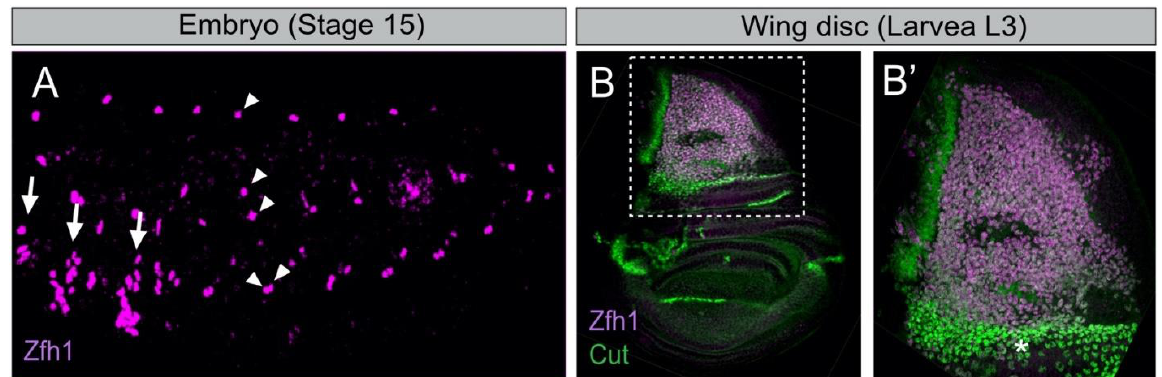
Figure 1. The Drosophila embryonic and wing disc associated muscle stem cells express the transcription factor Zfh1. ( A ) Stage 15 embryo stained for Zfh1 (magenta). Arrows and arrowheads indicate the thoracic and abdominal AMPs, respectively (adapted from [28]). The ventral abdominal AMP (V-AMP) is not shown in this sample. ( B ) Zfh1 (magenta) and Cut (green) are expressed in the wing disc AMPs. ( B’ ) Higher magnification of boxed region in B shows that high Cut expressing AMPs (asterisk) have low levels of Zfh1 (adapted from [16]).